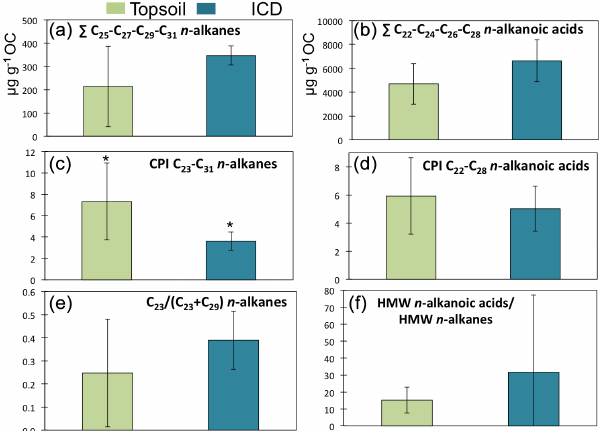
Figure 2. Molecular concentrations and ratios of topsoil Holocene permafrost (green, n = 9) and deeper Pleistocene permafrost (blue, n = 9) samples, with (a) the sum of odd n -alkanes C 25 –C 31 , (b) the sum of even n -alkanoic acids C 22 –C 28 , (c) the carbon preference in- dex (CPI) for n -alkanes C 23 –C 31 , (d) the CPI for n -alkanoic acids C 22 –C 28 , (e) the ratio of C 23 over C 23 + C 29 n -alkanes and (f) the sum of high-molecular-weight (HMW) n -alkanoic acids over HMW n -alkanes. The CPI is calculated as CPI i − n = 1 / 2 (cid:54) ( X i + X i + 2 + ... + X n )/(cid:54) ( X i − 1 + X i + 1 + ... + X n − 1 ) + 1 / 2 (cid:54) ( X i + X i + 2 + ... + X n )/(cid:54) ( X i + 1 + X i + 3 + ... + X n + 1 ) , where X is con- centration. Stars indicate that the two compared values are statisti- cally significant (95% confidence). Note that panel (a) and (b) are reported as median with IQR (interquartile range), and the other panels are reported as average ± standard